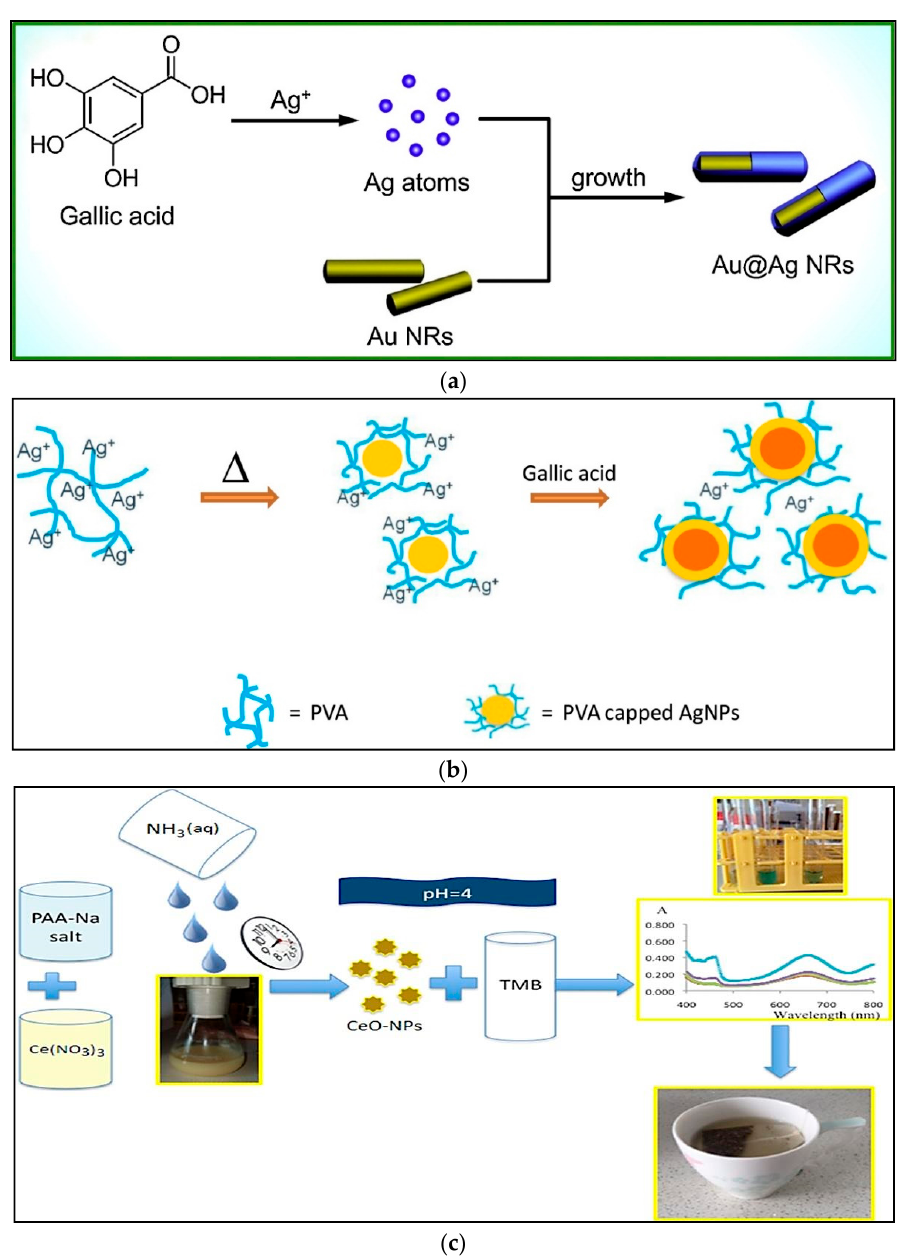
Figure 1. ( a ) Schematic illustration for the identification of gallic acid based on the seed-mediated growth, utilizing AuNRs and Ag + as the seeds and growth solution, respectively; ( b ) synthesis of PVA-AgNP seeds and formation of a silver nanoshell on the seeds caused by gallic acid; ( c ) a cerium oxide nanoparticle-based colorimetric sensor utilizing tetramethylbenzidine reagent for antioxidant activity analysis. Reprinted with permission from [17,34,37],